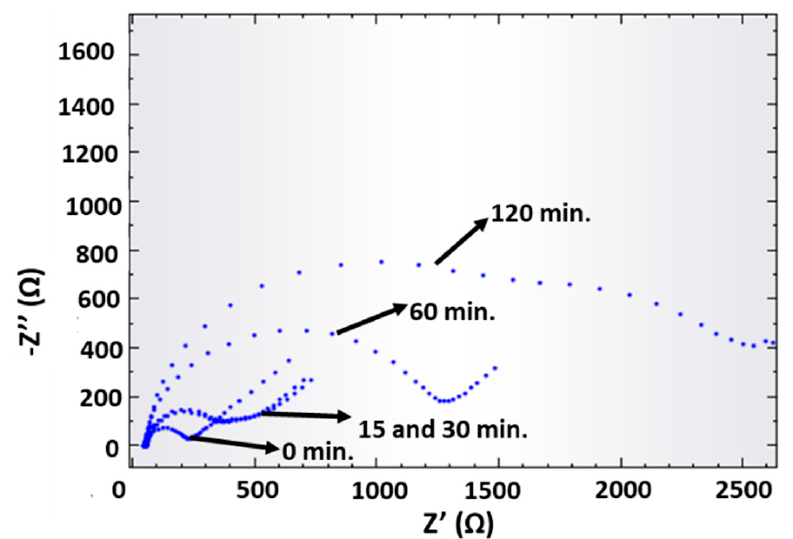
Figure 3. Nyquist plots that were obtained before (0 min) and after (15, 30, 60, 120 min) the interaction of MWCNT-Au-Pt/AuSPE with cysteamine.